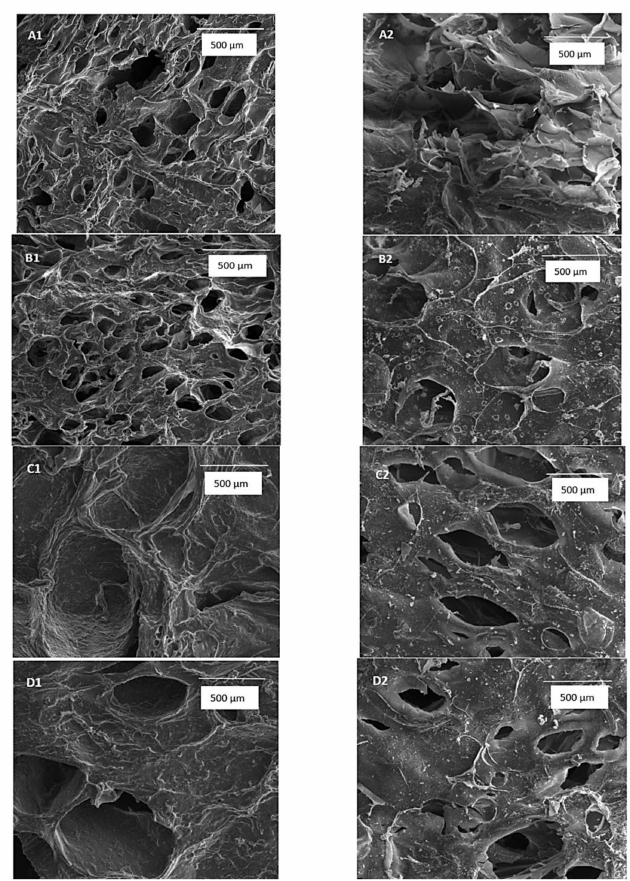
Figure 4. Scanning electron microscopy of hydrogels ( A ) without TA; ( B ) 10% TA; ( C ) 20% TA and ( D ) 30% TA, (1) before immersion in SBF and (2) after 7 days at 150 × magnification